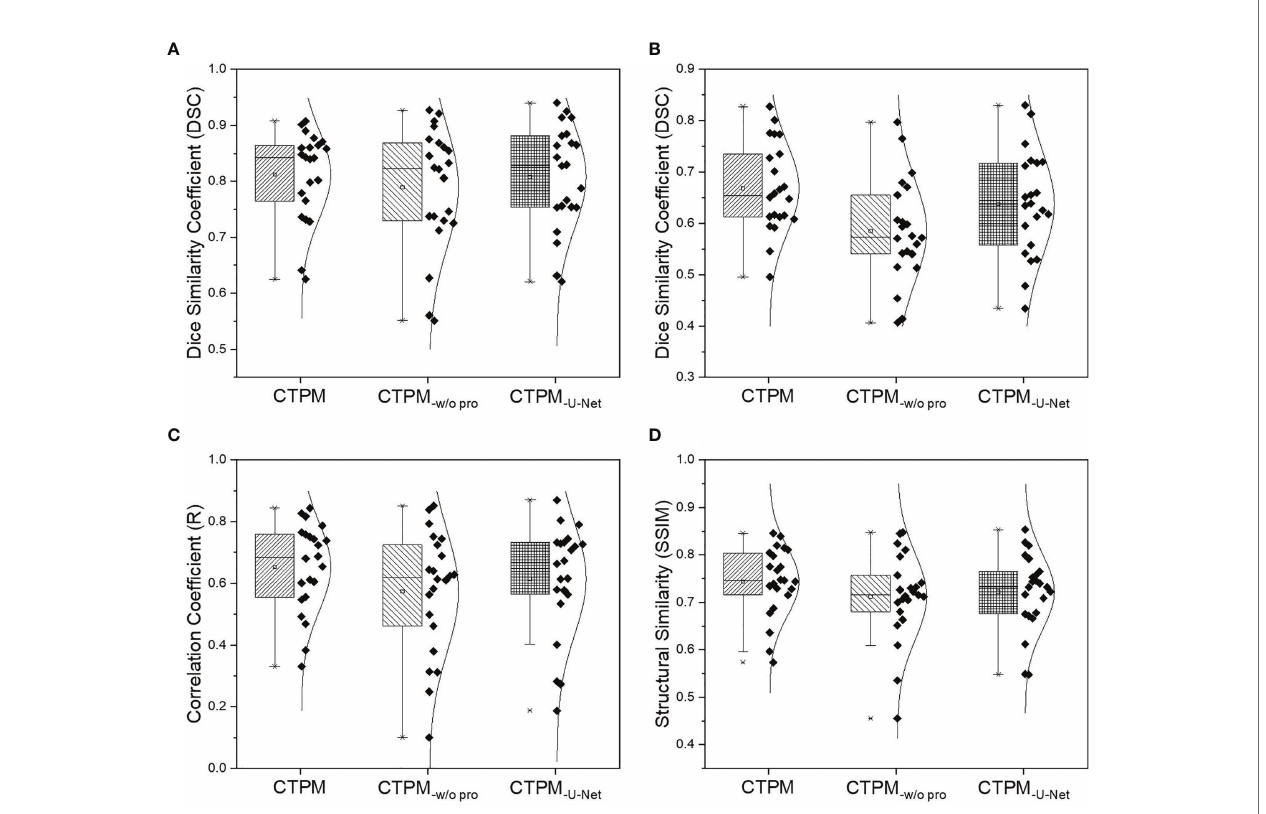
FIGURE 5 | Overall performance analysis of the CTPM framework for the testing group. (A) DSC of the high functional lung. (B) DSC of the low functional lung. (C) Correlation coef fi cient. (D) Structural similarity. CTPM -w/o pro indicates prediction without image processing. CTPM -U-Net indicates prediction using